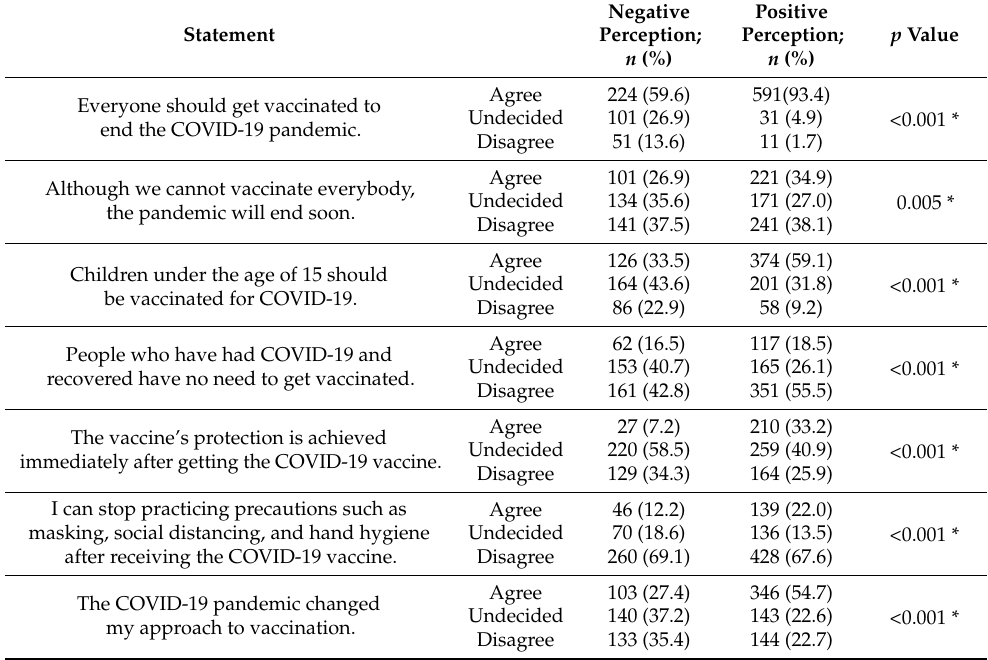
Table 3. Comparison knowledge and practice of study participants toward COVID-19 vaccine according to perception. * p <